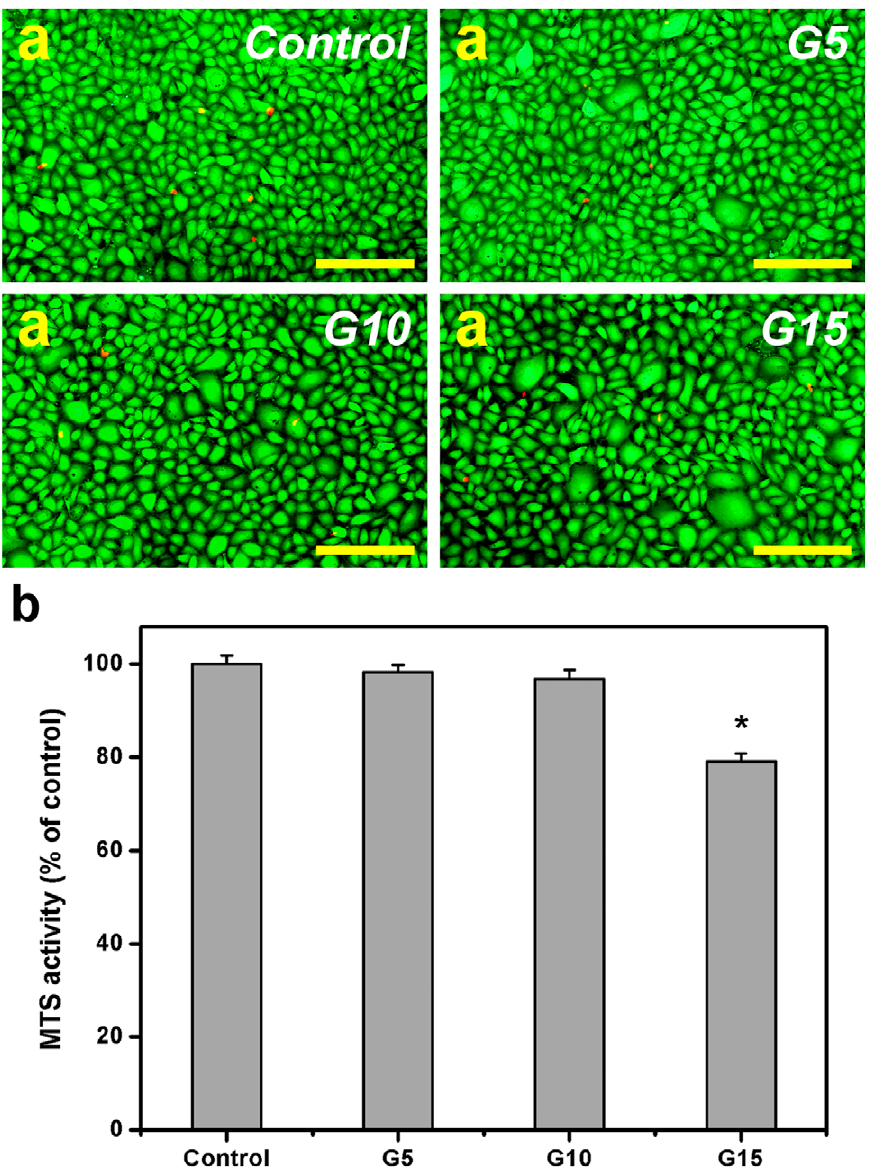
Figure 7. Cell viability and proliferation assays. (a) Cell viability of rabbit corneal endothelial cell cultures was determined by staining with Live/ Dead Viability/Cytotoxicity Kit in which the live cells fluoresce green and dead cells fluoresce red. Fluorescence images of cells in controls (without gelatin materials) after 12 h of direct contact with different types of gelatin samples. Scale bars: 100 m m. (b) Cell proliferation assay of rabbit corneal endothelial cell cultures after 12 h of direct contact with various gelatin samples. Results are expressed as percentage of control groups (MTS activity of cells cultured in the absence of gelatin materials). An asterisk indicates statistically significant differences (* P , 0.05; n =5) as compared with the control